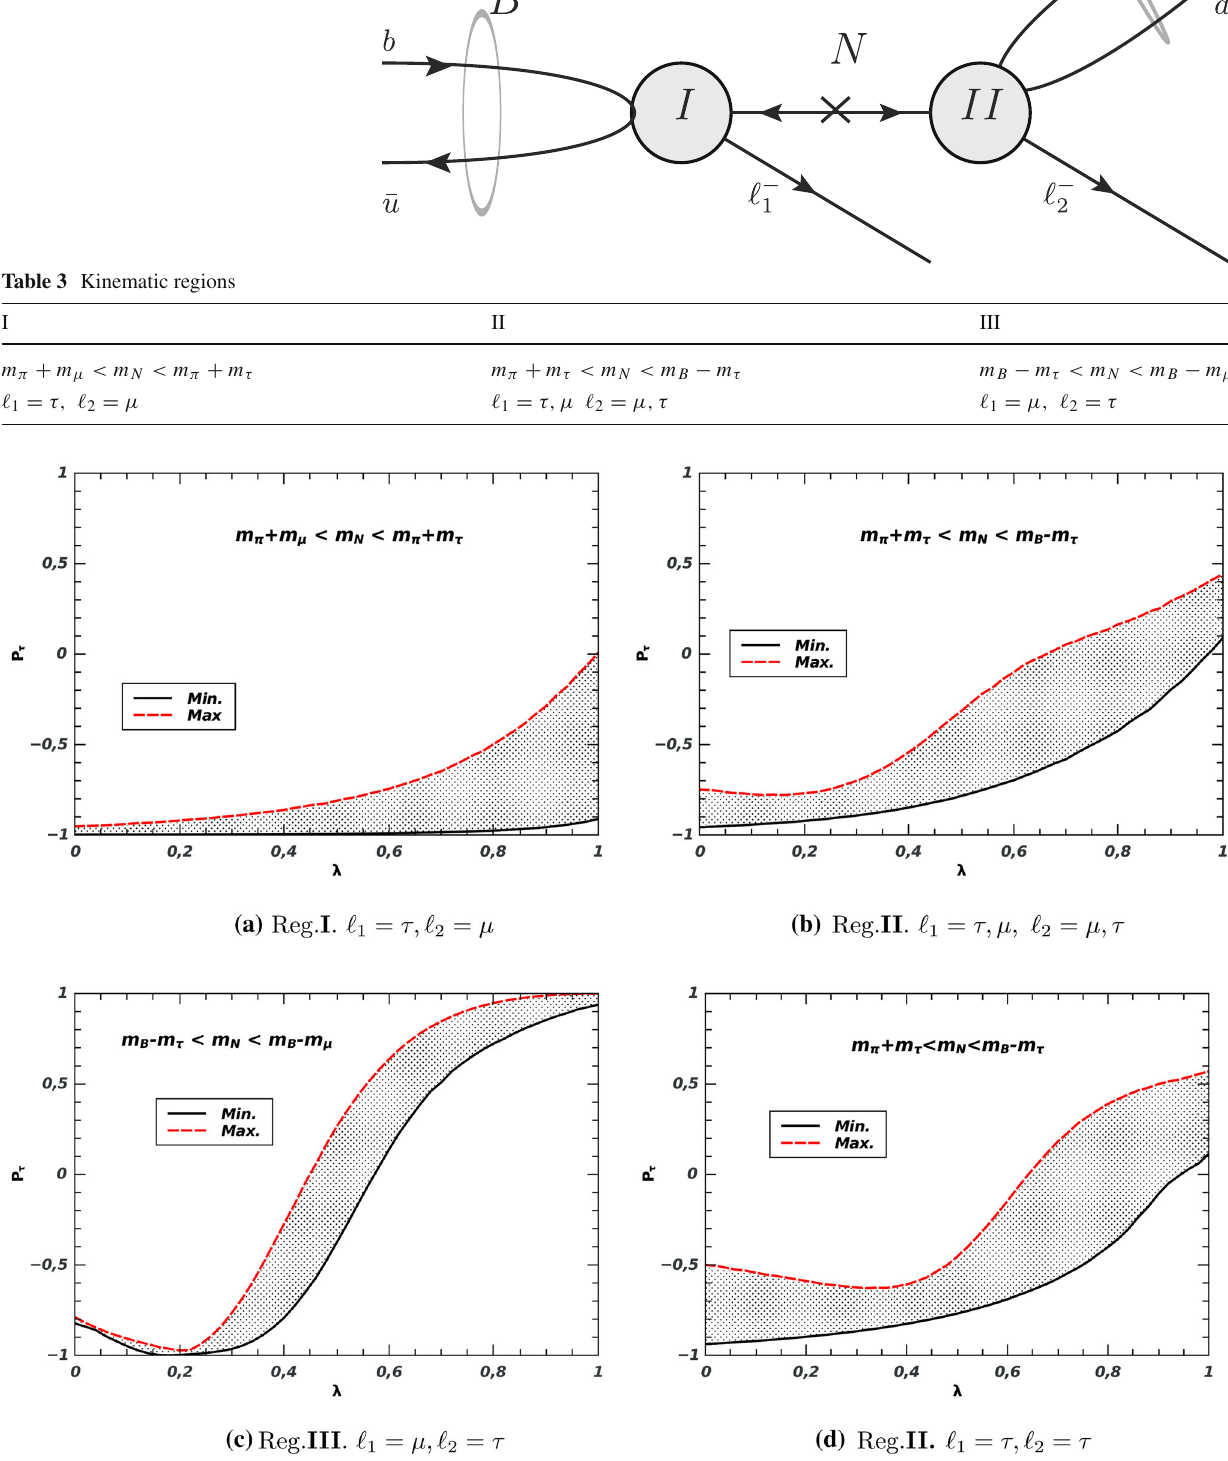
Fig. 7 Final-state polarization P τ for the different kinematic regions I, II and III defined in Table 3. For λ = 1 only vectorial interactions are considered, and for λ = 0, only